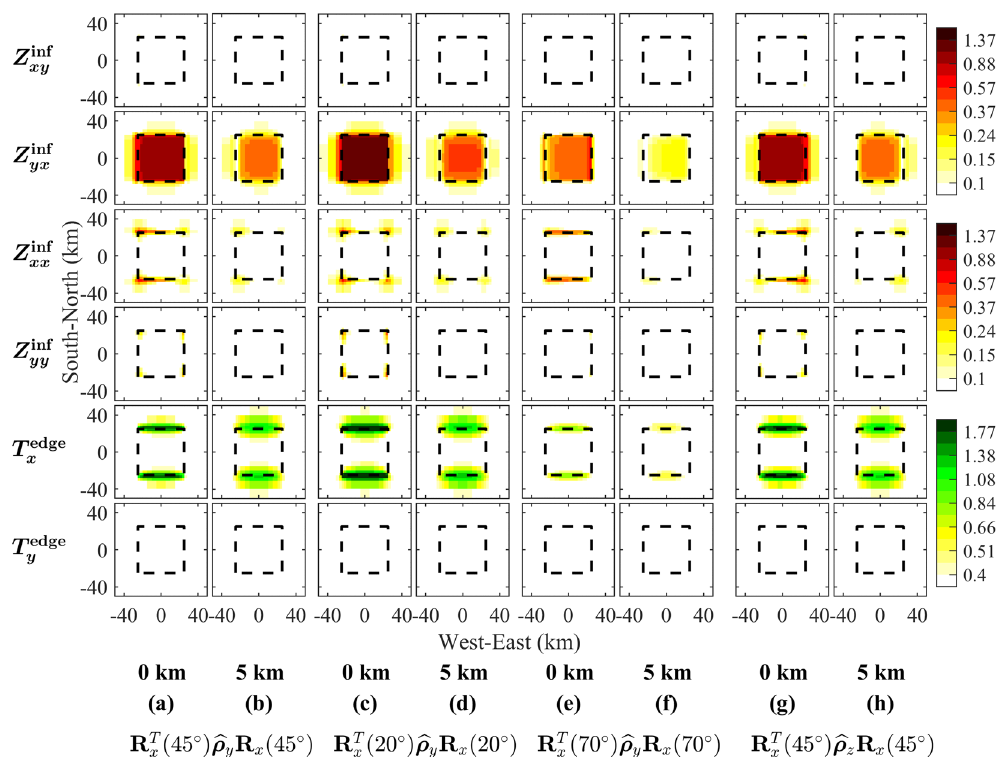
Fig. 5 The surface logarithmic plot of Z inf xy ( s ) , Z inf yx ( s ) , Z inf xx ( s ) , and Z inf yy ( s ) , and T edge x ( s ) , and T edge y ( s ) at all 484 stations from top to bottom rows, respectively, obtained when the 3‑D anisotropic body in Fig. 1 (shown as dashed line) is assigned with R T x ( 45 ◦ ) surface (0 km), and b 5 km deep, given f . In addition, when the 3‑D anisotropic body is assigned with R T x ( 45 ◦ )